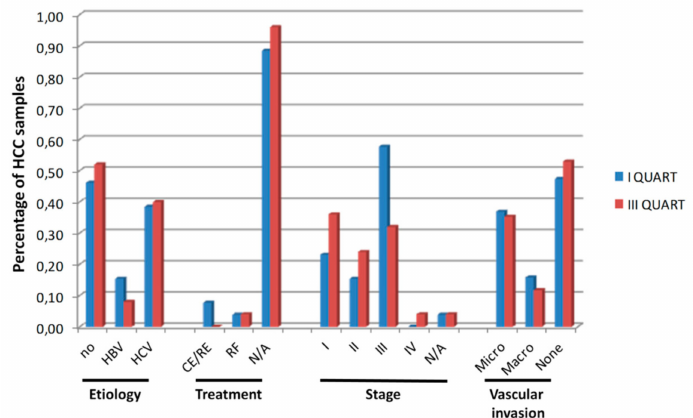
Figure 4. Clinical characteristics of HCC samples. The percentage of HCC samples with the indicated characteristics in the I and III quartiles of number of neoantigens is shown. CE / RE = chemo and radioembolization; RF = radiofrequency. HBV:Hepatitis B virus; HCV: Hepatitis C virus; NA: Not available no:Not